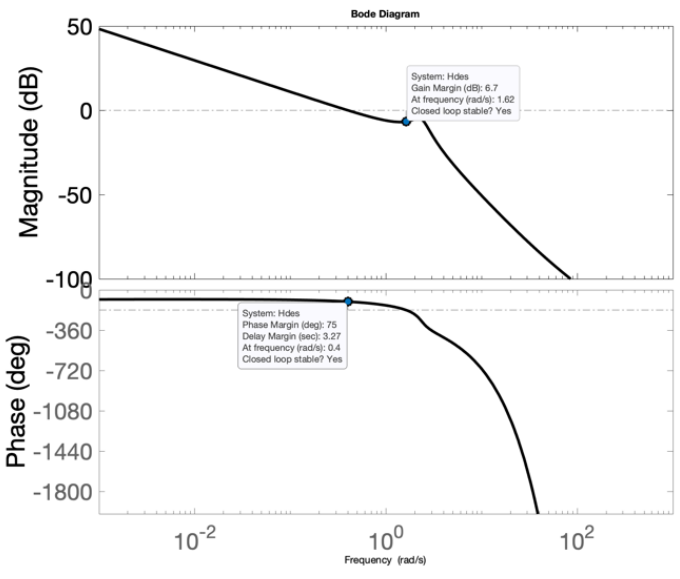
Figure 8. Bode diagram of the open loop system.